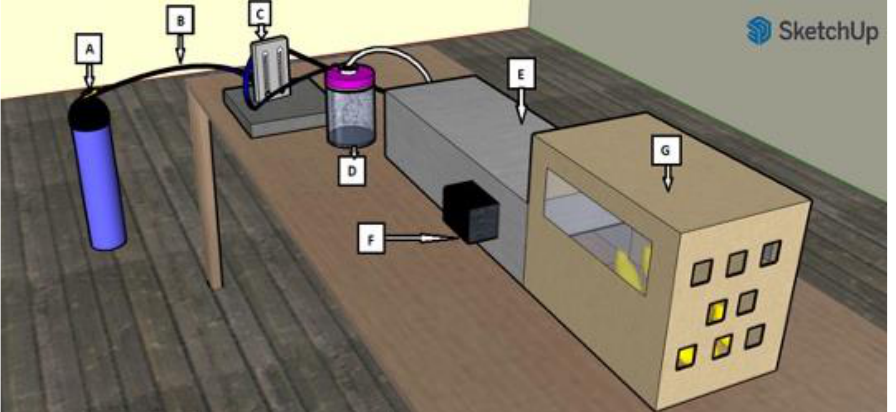
Figure 1. Graphical representation of the settings for nebulization and irradiation of the aerosol: (A) air flow source, (B) T junction, (C) float-type flowmeter, (D) nebulizer, (E) irradiation chamber, (F) UVC (222 nm) lamps, (G) box housing the birds (SketchUp © 2022, Trimble Inc., Sunnyvale, CA,